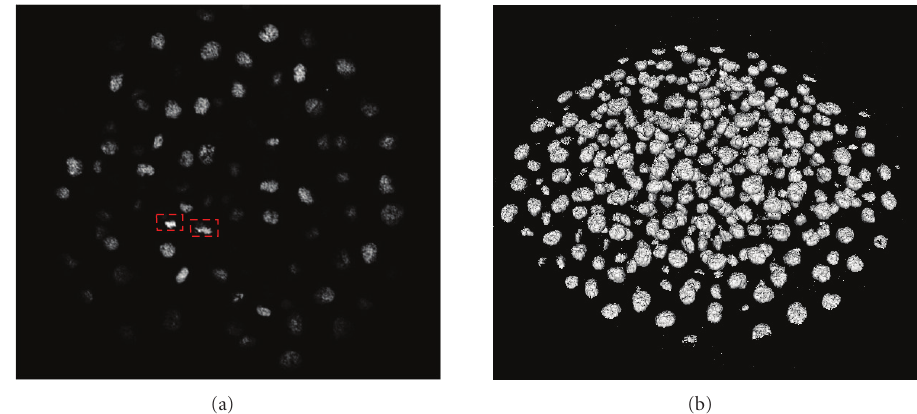
Figure 2: Original data. Volume selected in the middle of the time lapse series. (a) Orthoslice on the xy plane. Nuclei in mitosis are surrounded by a red rectangle in dotted line. (b) Isosurface value of